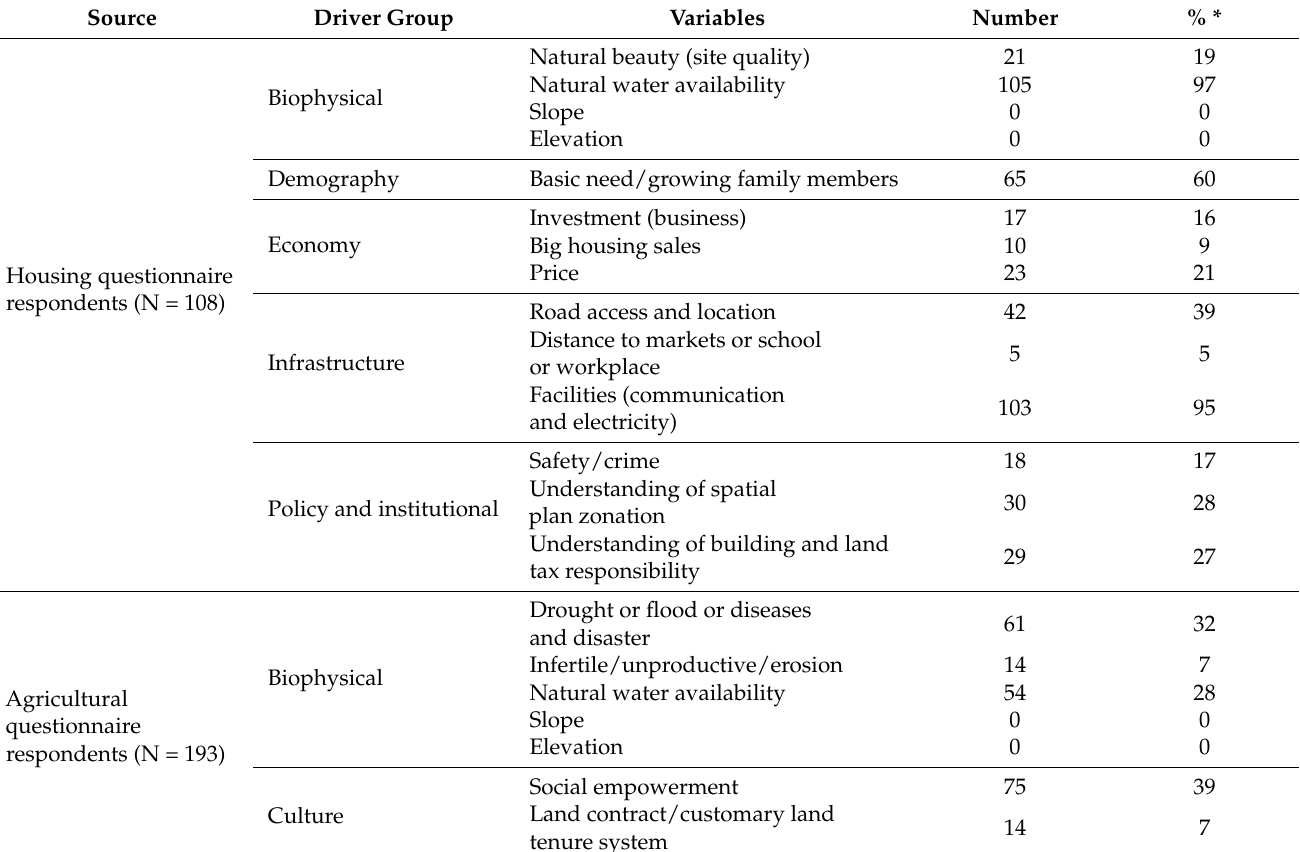
Table 5. Distribution of respondents’ responses on factors affecting land-use